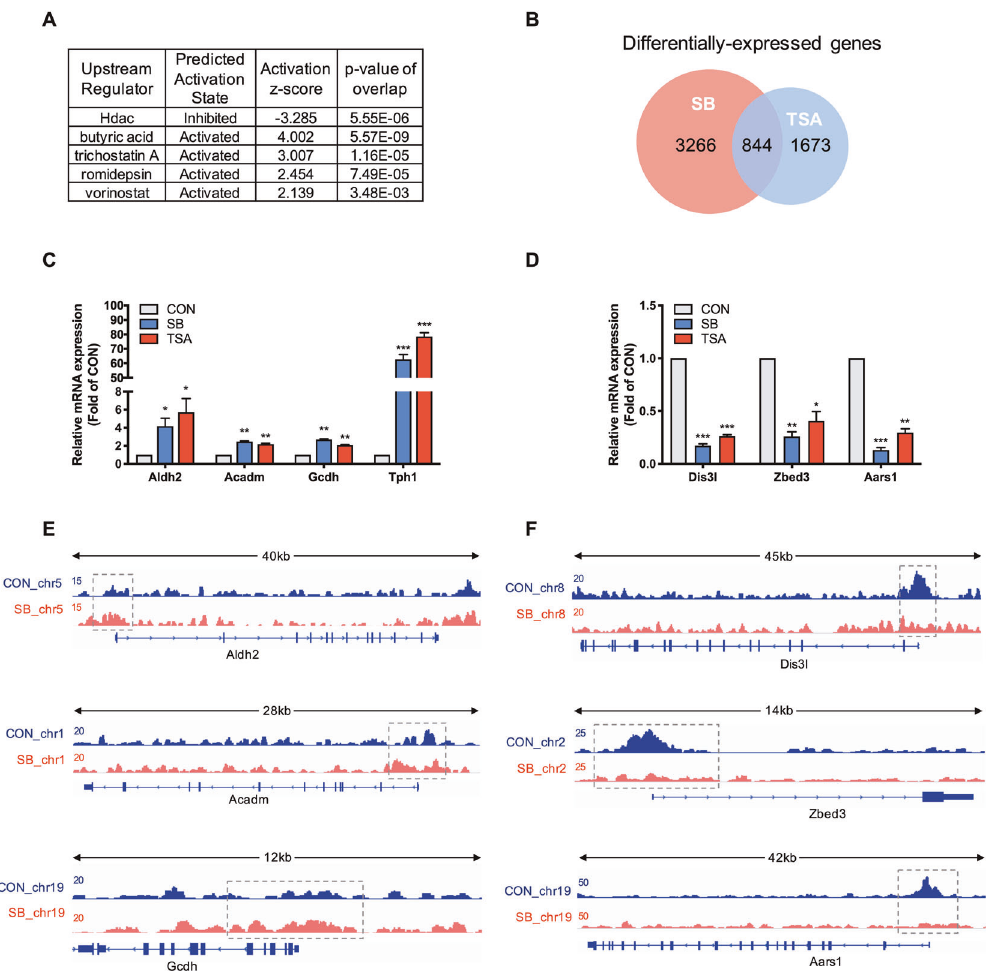
Fig. 4 Comparative analysis of the gene expression pro fi les from sodium butyrate- and trichostatin A-treated rat islets. A Upstream regulator analysis of Ingenuity Pathway Analysis (IPA) on sodium butyrate (SB)-regulated genes. B Overlapping differentially expressed genes in rat islets regulated by both SB and trichostatin A (TSA). C , D RT-qPCR analysis of commonly upregulated and downregulated genes in rat islets by 5 mM SB and 200 nM TSA. E H3K27Ac patterns of Aldh2, Acadm, and Gcdh from ChIP-seq. Gene structure and chromosomal location are shown, with the gray dotted box highlighting the upregulated peaks in their promoter regions by SB. F H3K27Ac patterns of Dis3l, Zbed3, and Aars1 from ChIP-Seq. Gene structure and chromosomal location are shown, with the gray dotted box highlighting the downregulated peaks in their promoter regions by SB. Data were given as mean ± SD for three separate experiments. * p < 0.05, ** p < 0.01, *** p < 0.001 vs control (CON)